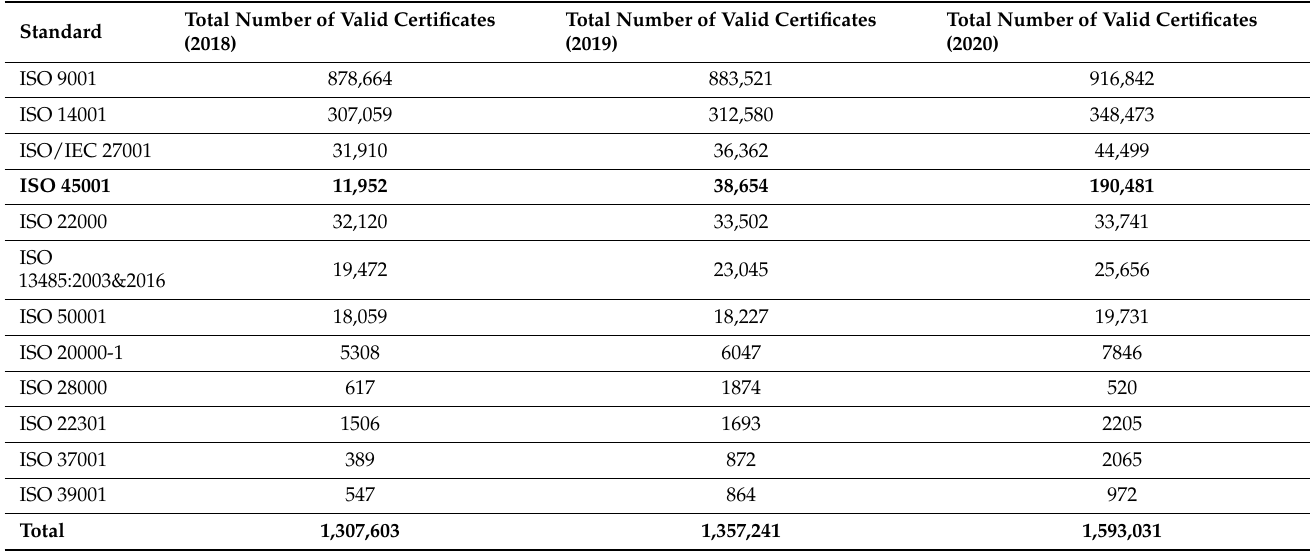
Table 2. Number of valid certificates worldwide (comparison of 2018, 2019, and 2020) [16].